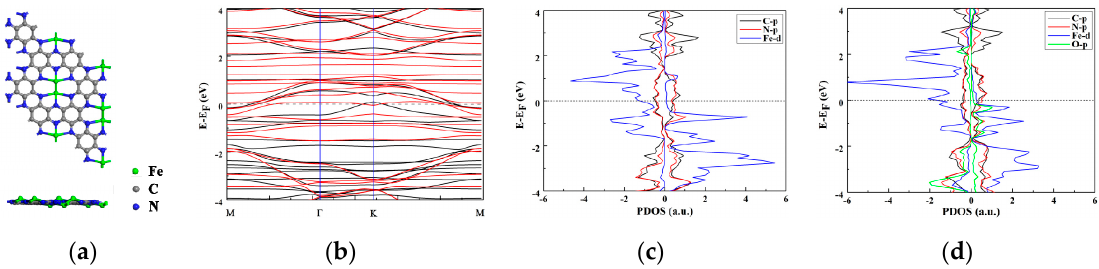
Figure 1. ( a ) Top and side view of the structure of Fe 2 @C 2 N in a 2 × 2 × 1 supercell; ( b ) Band structure; ( c ) and ( d ) Projected density of state (PDOS) of the Fe 2 @C 2 N and Fe-O-Fe@C 2 N intermediate. The Fermi level is set to zero.